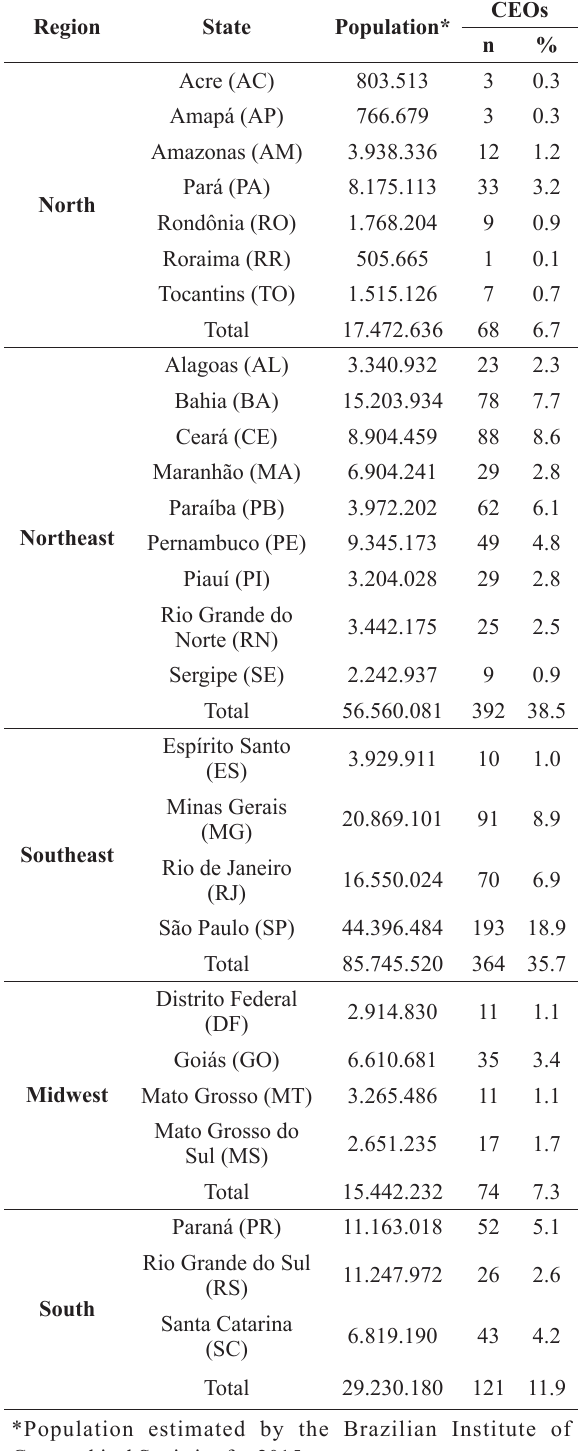
Population data of the Brazilian regions and the number of